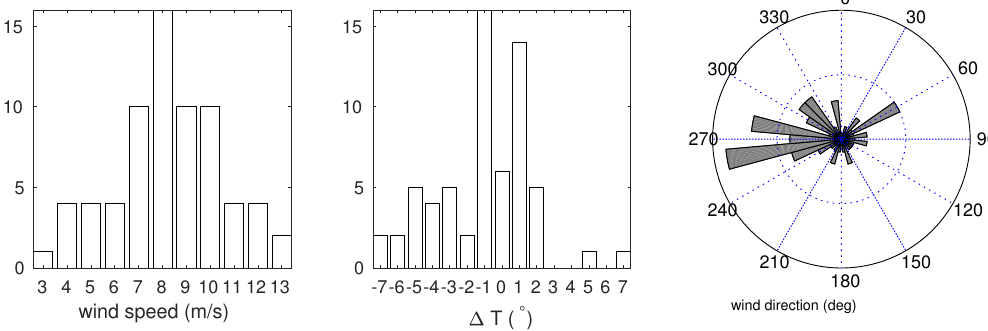
Figure 2. Geophysical conditions in the areas imaged by the SARs used in this work according to the analysis data of the European Centre for Medium-range Weather Forecasts (ECMWF) model. Left panel : wind speed distribution. Middle panel: air-sea temperature difference distribution. Right panel : wind direction